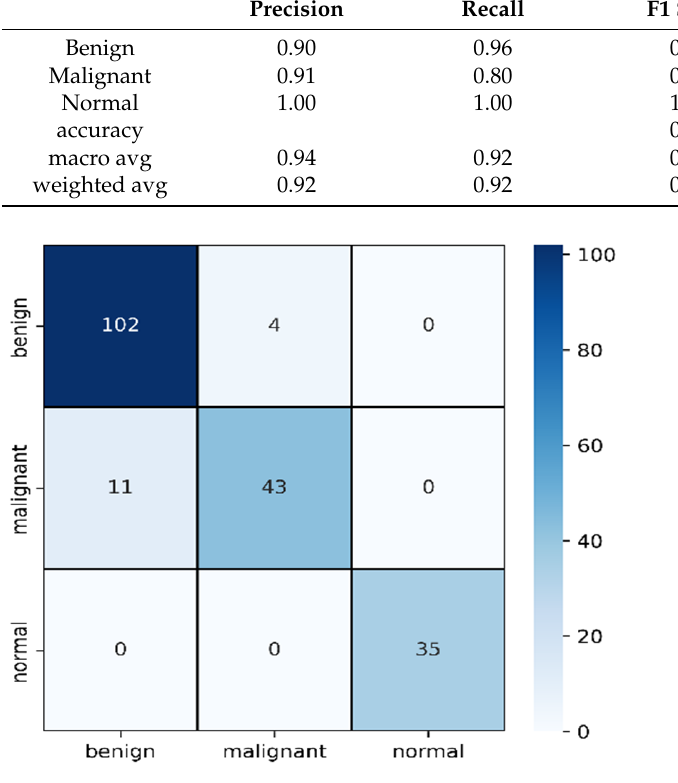
Figure 13. Confusion matrix for combined image evaluation on 25% of test data.